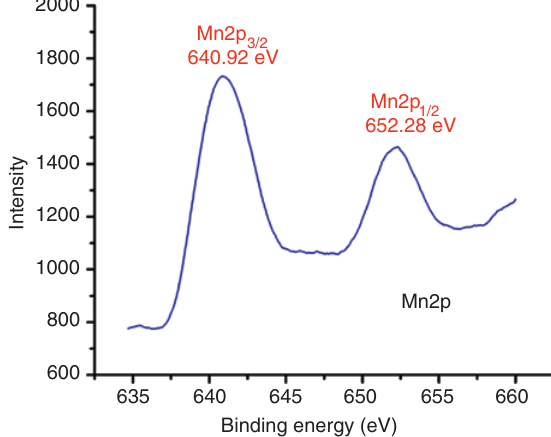
Figure 3: XPS spectra of MnNPs for Mn 2p